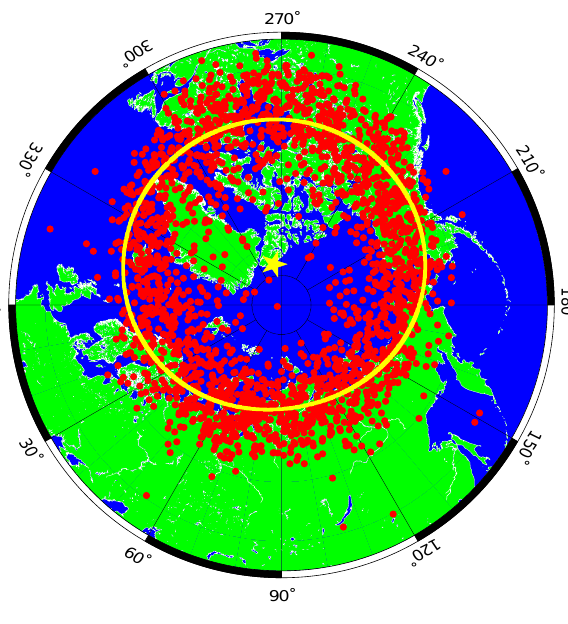
Fig. 3. Circle fit to the distribution of Formosat-3/COSMIC profiles which statisfy the ELDI condition. The yellow star marks the center of the circle fitted to the data, which coincides with the geomagnetic pole.